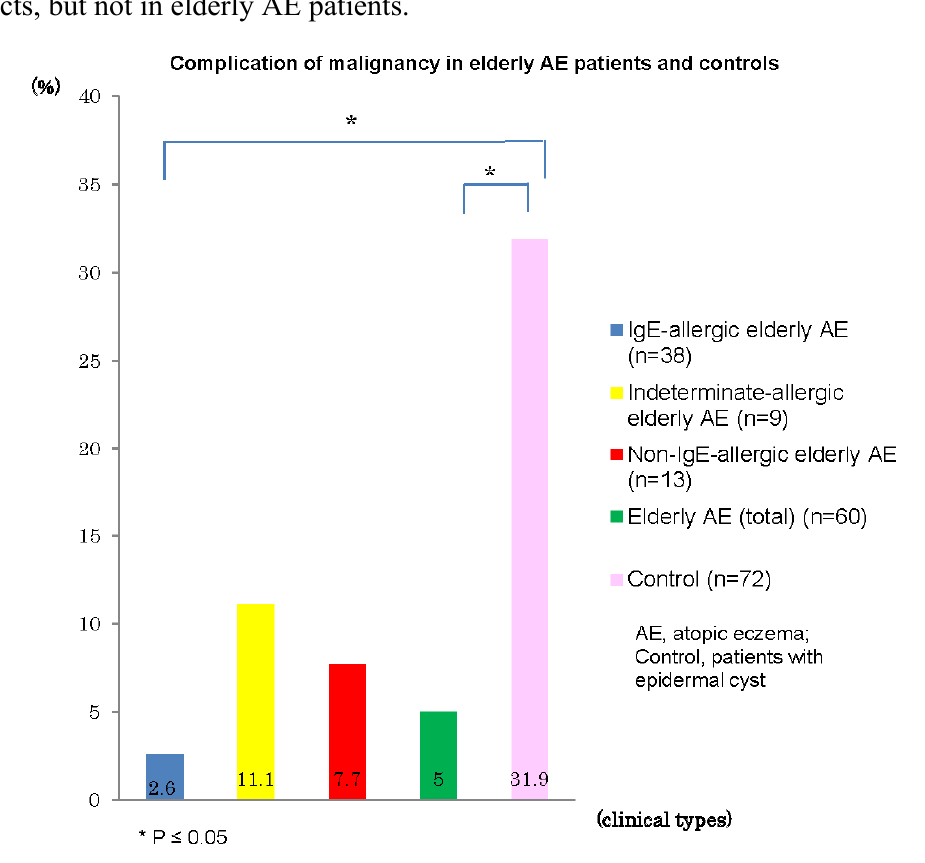
Figure 7. Complication of malignancy in elderly patients with atopic eczema and